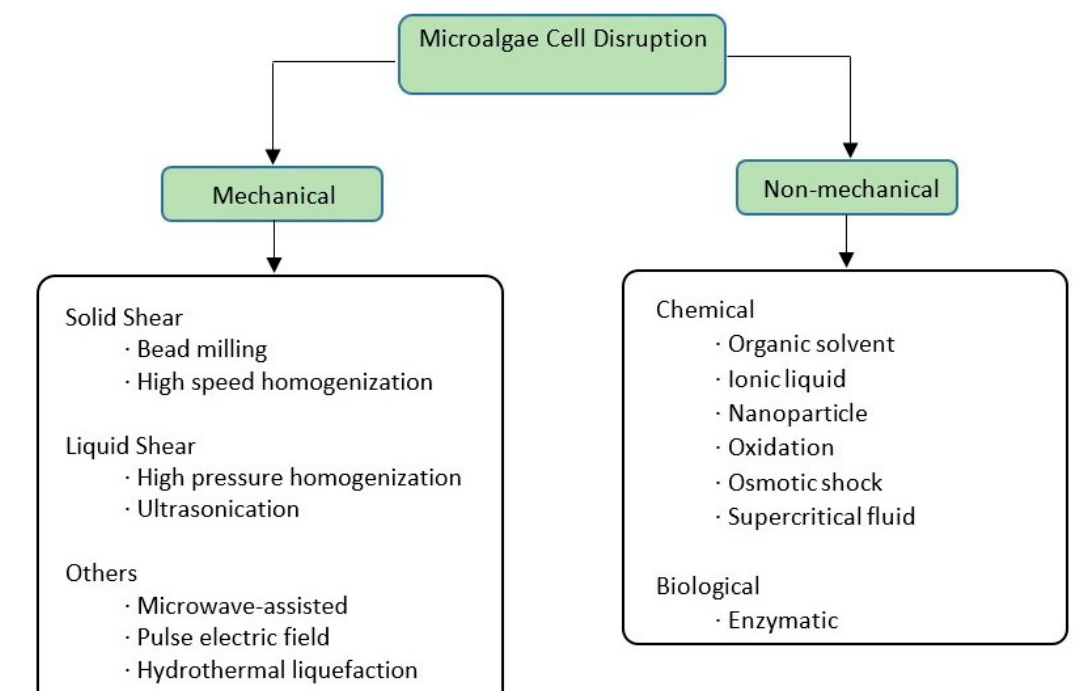
Figure 5. Various ways for disrupting microalgae cell wall [76,88].